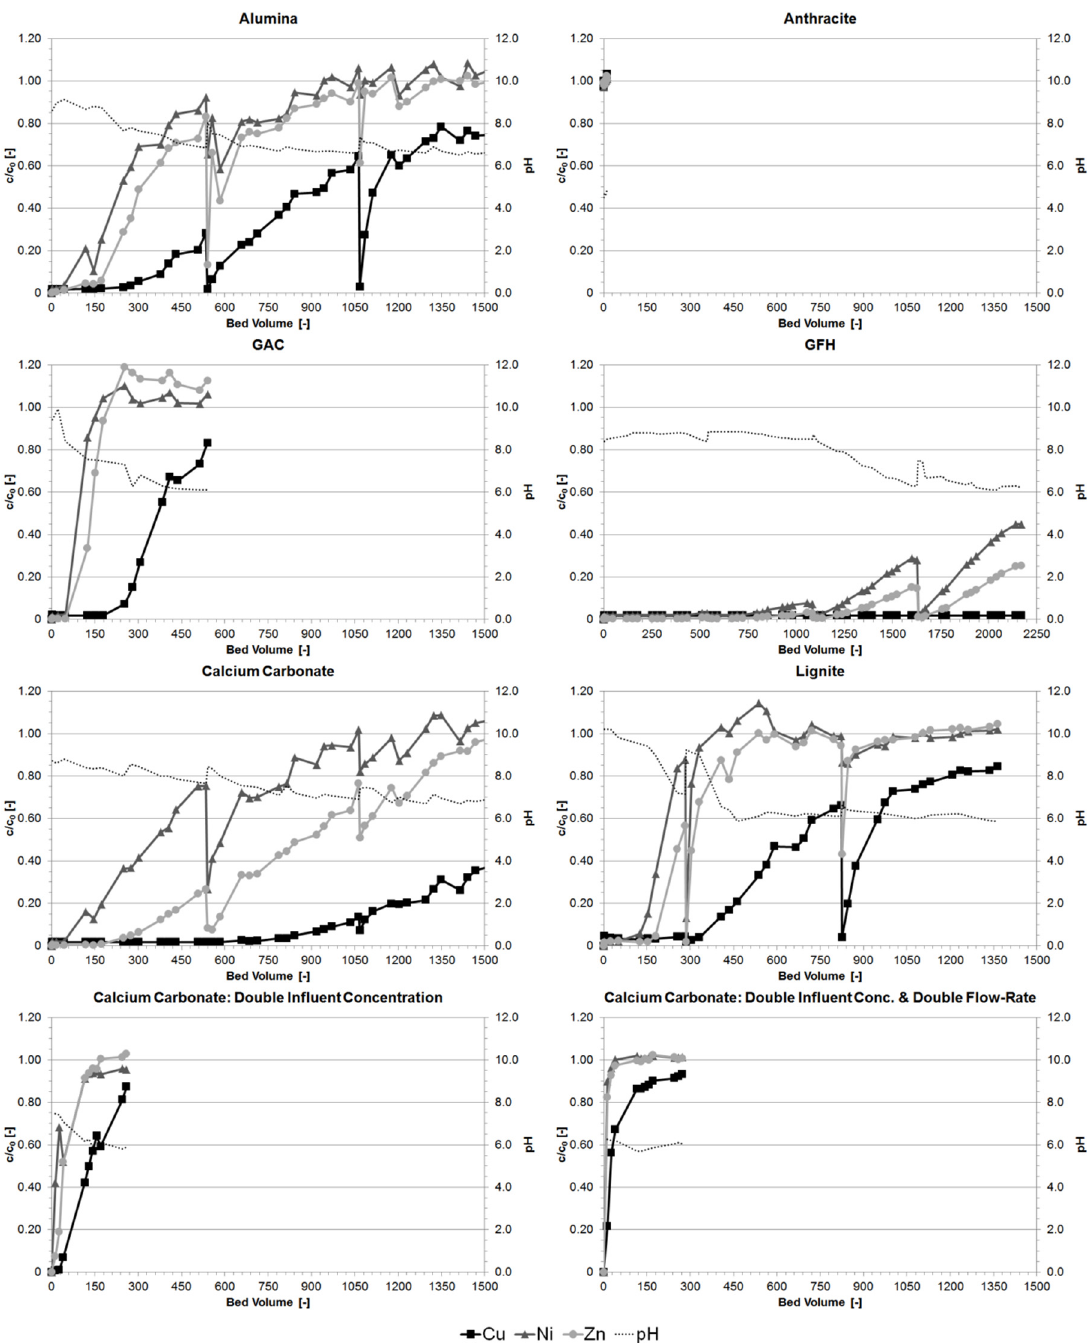
Figure 5. Heavy metal removal and pH drift curves of all column experiments conducted with influent concentrations of 2.5 mg/L Cu, 2.5 mg/L Ni, and 5.0 mg/L Zn at a flow-rate of 6.5 mL/min (exceptions: two calcium carbonate experiments with variations; GFH has a different scale).